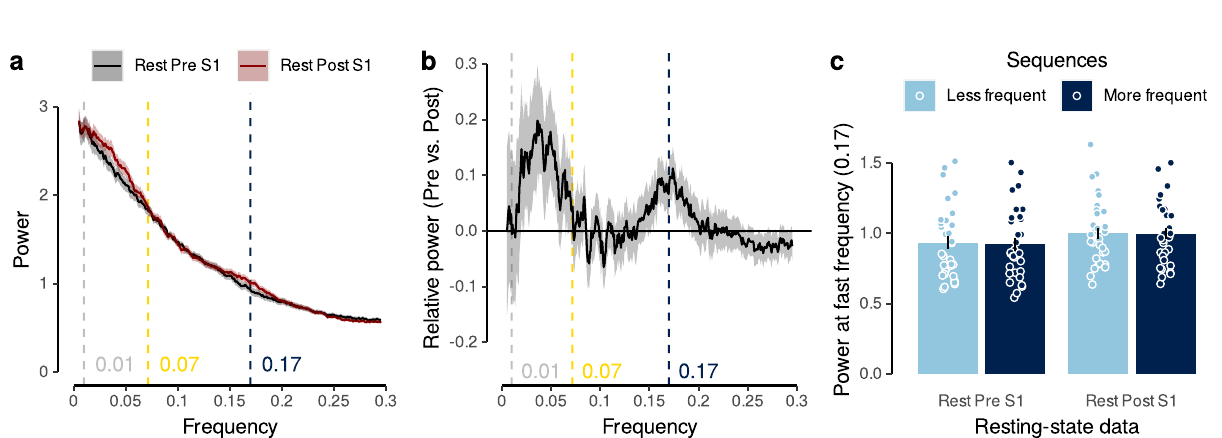
Fig. 6 Detecting fast task-related reactivations in post-task resting-state data. a Normalized frequency spectra of regression slopes in pre- and post-task resting-state data. Annotations indicate predicted frequencies based on Eq. (5). Shaded areas represent ±1 SEM. b Relative power (difference between pre- and post-task rest) of normalized frequency spectra shown in (a) ( n = 32, F 1,94.99 = 6.17, p = 0.02, LME model comparing pre- vs. post-task resting-state data at 0.17 Hz). c Mean power at predicted fast frequency (0.17 Hz) in pre- and post-task resting-state data for less and more frequent stimulus sequences ( n = 32, t s ≥ 4.17, p s < 0.001, d s ≥ 0.74, two two-sided paired t -tests comparing rest and 2048 ms conditions against 32 ms condition, FDR- corrected). Each dot corresponds to averaged data from one participant. Error bars represent ±1 SEM. All statistics have been derived from data of n = 32 human participants who participated in one experiment. Source data are provided as a Source Data fi